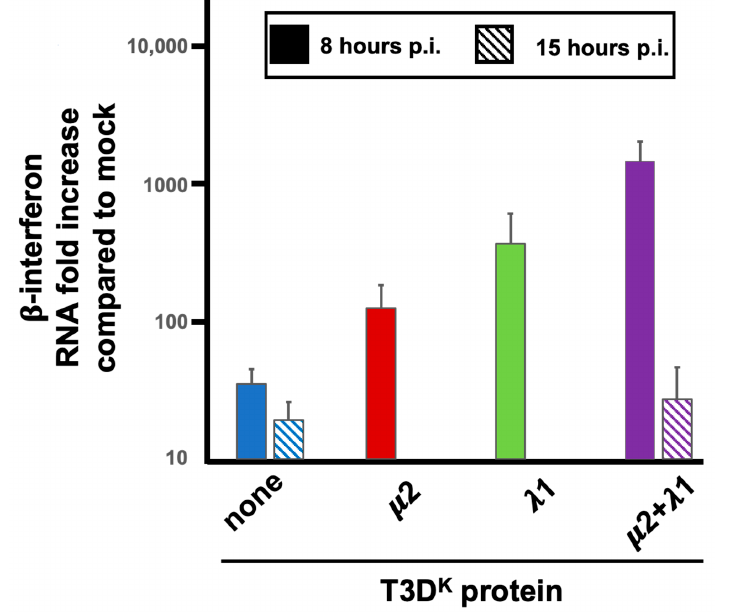
Figure 9. Interferon mRNA induction by RNA recovered from infected cells. L929 cells were infected at a MOI of 10 TCID 50 units/cell with the different viruses in the T3D S genetic background with either no substitution (none) or substitution of the μ 2, λ 1, or both proteins of T3D K , as before. Total RNA was recovered at either 8 h or 15 h post-infection with the different viruses, as indicated and as described in the text. RNA was introduced by transfection, as described in Materials and Methods, and cells were recovered 8 h post-transfection. The experiment was repeated twice for singly sub- stituted viruses (biological replicates) with RNA extracted at 8 h post-infection and each quantifica- tion reaction was performed in triplicates (technical replicates). The experiment with both other vi- ruses was done in biological triplicates with RNA recovered at early or late time postinfection. The data were normalized to the control housekeeping gene, the mock sample was attributed a value of “one”. Even though clear difference was observed between RNA recovered at 8 h for the different viruses, statistical significance was not reached in these experiments ( p = 0.07). We then verified if RNA extracted from cells infected by the two singly substituted viruses behave as intermediate between T3D S and the doubly substituted virus. It turns out to be the case (Figure 9), indicating that the nature of the RNA inducer is, once again, dependent on both μ 2 and λ 1. 4. Discussion In the present study, we revisited and extended our previous results showing that both μ 2 and λ 1 are involved in the control of interferon synthesis. We further showed control of induction of β -interferon mRNA at the transcriptional level, and that the two proteins exert a combined action resulting in maximal impact on interferon induction. The intermediate level of induction observed upon co-infection with high- and low- inter- feron-inducing virus suggests that the two proteins do not exert their effect by their pres- ence in the infected cell, but rather by their presence in the infecting viral particles. Analysis of sequences available for both the μ 2 and λ 1 proteins indicates that for the three polymorphisms examined herein (position 208 and 342 of μ 2 and position 500 in λ 1), the sequence of T3D S is by far the most frequent and found in more than 90% of the